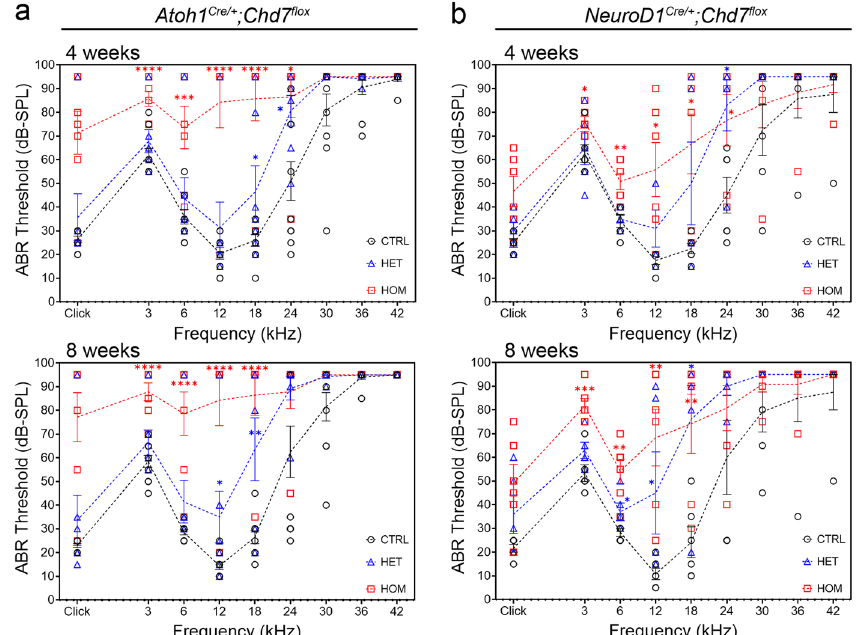
Fig. 4 Postnatal degeneration of hair cells and neurons in Chd7 mutants. a Auditory brainstem response (ABR) tests of Atoh1 Cre/ + ;Chd7 fl ox mutants and controls at 4 weeks and 8 weeks reveals profound hearing loss in homozygous and mild-moderate hearing loss in heterozygous Chd7 mutants across all frequencies. b ABR tests of NeuroD1 Cre/ + ;Chd7 fl ox mutants and controls at 4 weeks and 8 weeks reveals mild-moderate hearing loss in homozygous mutants. Frequencies where signi fi cant threshold elevations were observed are indicated by asterisks ( P -values: *< 0.05, **< 0.005, ***< 0.0005, ****< 0.000005). See Figs. S5 and S6 for ABR pro fi les of each mouse. Error bars represent the standard error of mean (see Figs. S5 and S6). CTRL = control; HET = heterozygote; HOM =